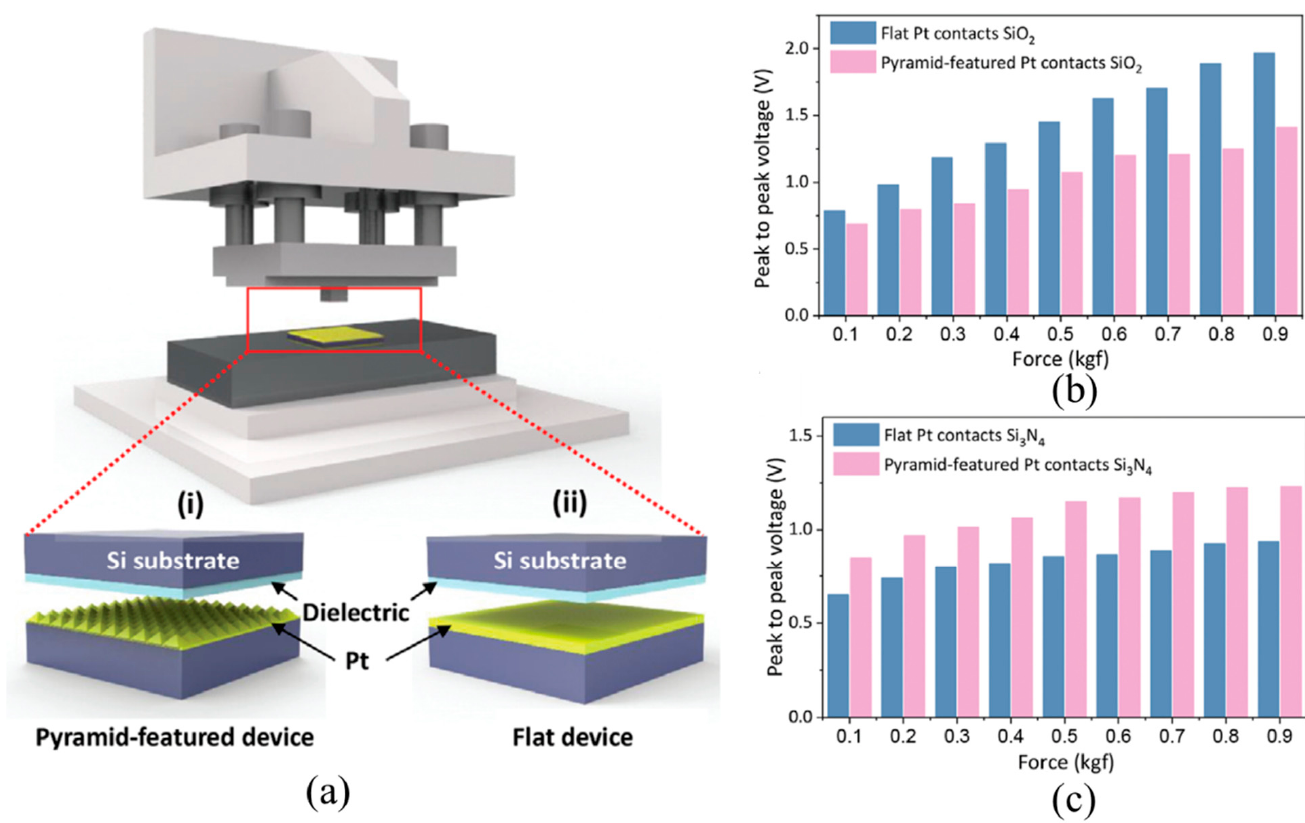
Figure 26. Energy band diagram of metal ‐ Si (p ‐ type) contact under ( a ) no strain gradient, ( b ) posi ‐ tive strain gradient, and ( c ) negative strain gradient. The effect of the induced flexoelectric polariza ‐ tion on the ( d ) maximum rectified current density, ( e ) reverse saturation current density, ( f ) rectifi ‐ cation ratio, and ( g ) open voltage for silicon ‐ based Schottky barrier diode devices. The red dots are the experimental results and the blue dotted lines are their fitted curves. Reprinted with permission from [90]. Copyright 2021 Elsevier.